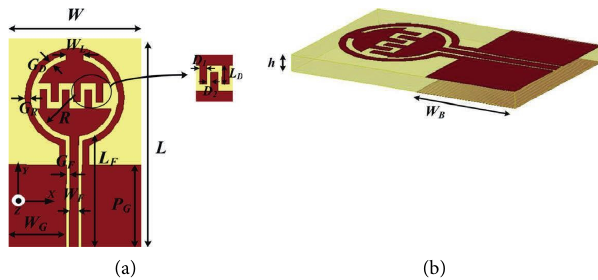
Figure 2: Geometry of proposed dual-band metamaterial antenna ( L � 25, W � 16, P